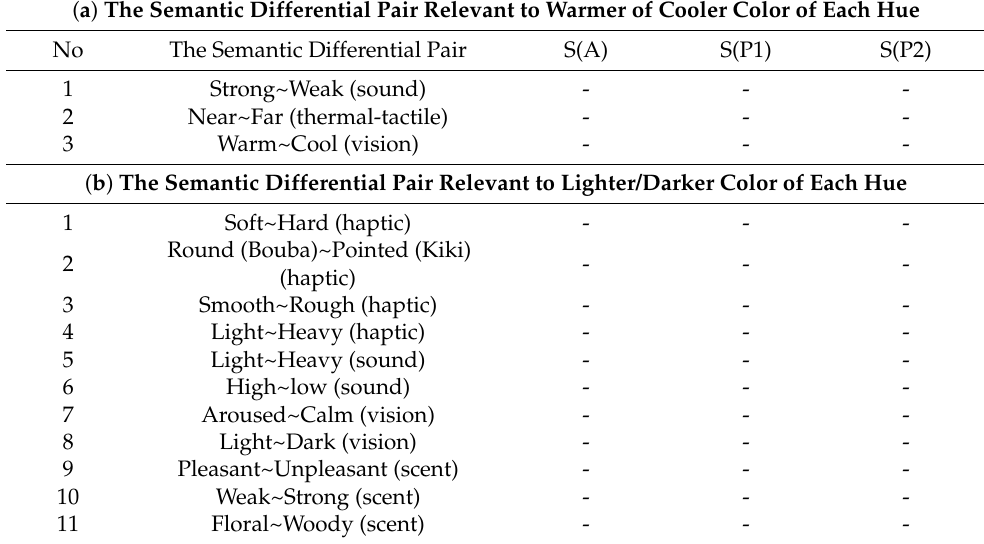
Table 8. An implicit association test questions for the case of color stimuli “Blue sky and night” in artwork associated with Poem 1 and Poem